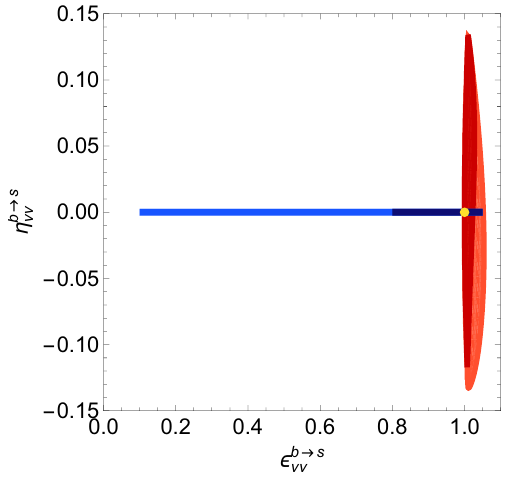
Figure 9. The correlations of the quantities (cid:17) and (cid:15) , which determine the observables in the b s(cid:23) (cid:22) (cid:23) sector in G SM -scenarios for M VLQ = 10 TeV [darker] and 1 TeV [lighter] within the 95% ! CL regions. The colours are for VLQ-representations D [Blue] (similar to T u;d ), Q V = Q d